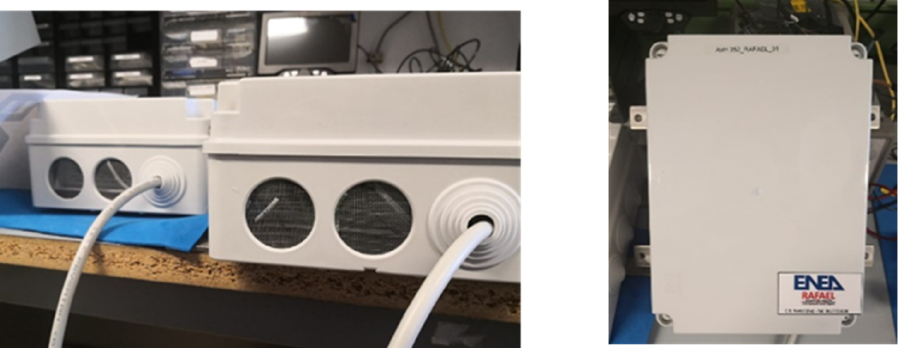
Figure 1. The Measuring Station. The IoT ENEA Monica™ monitor is enclosed, for this experiment, within a box, whose only connection with the surrounding environment is through two 5 cm 2 holes covered by fi ne metallic grids to avoid possible penetration of small animals.